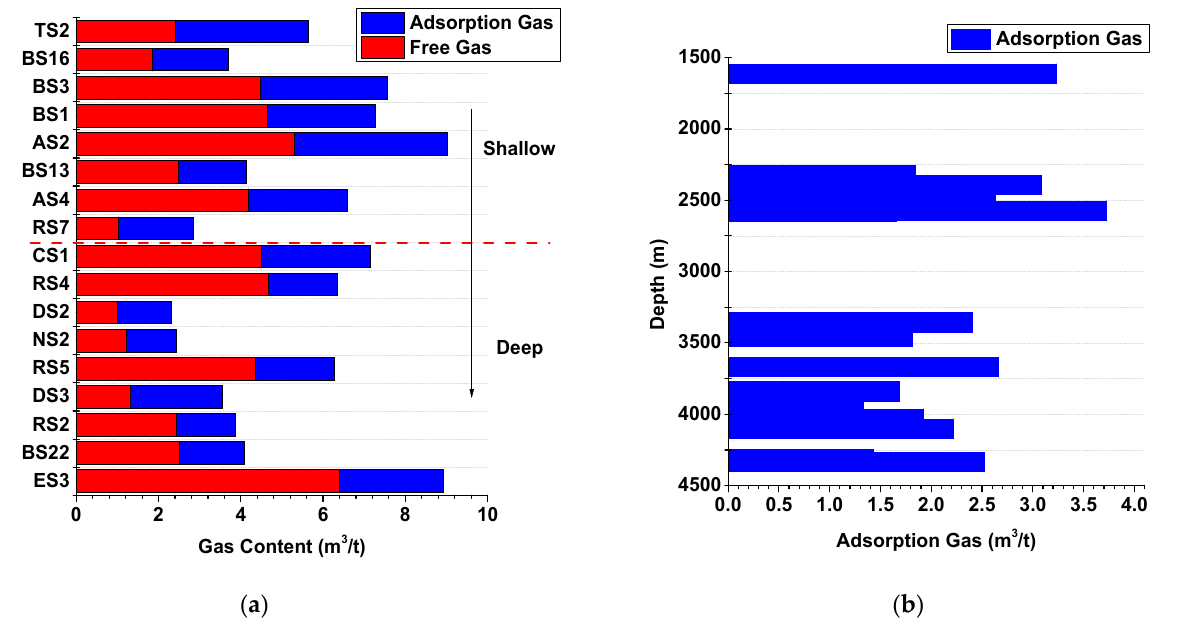
Figure 5. Comparison of gas content. ( a ) Total gas content. ( b ) Adsorption gas content.